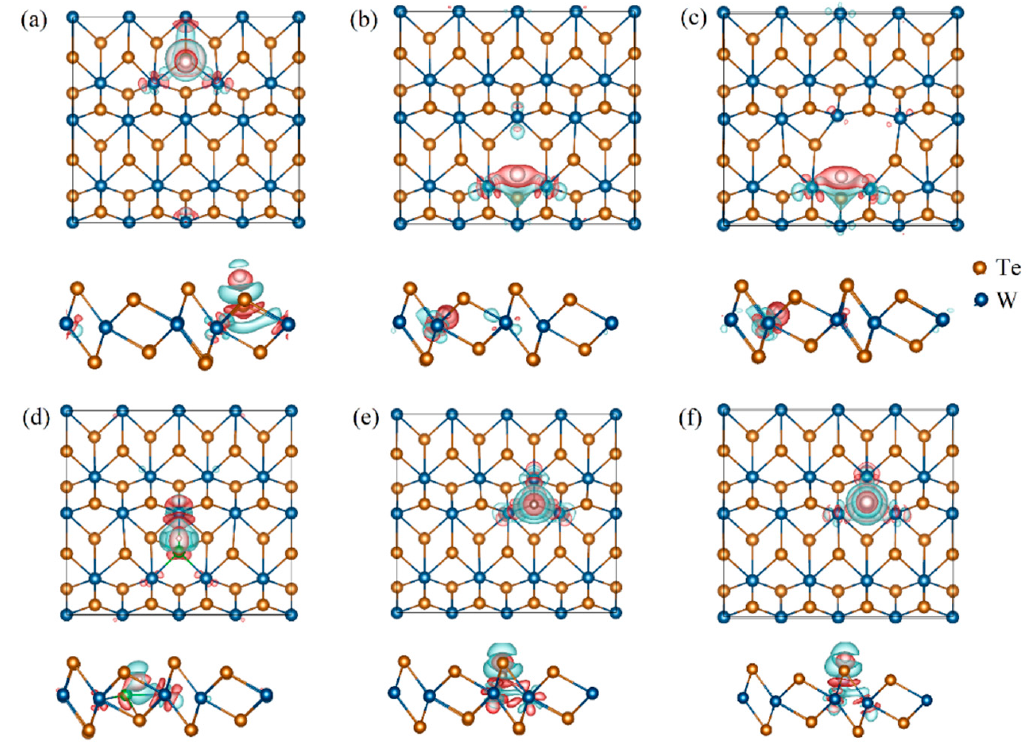
Figure 5. Difference in the charge densities of WTe 2 with an H adsorption system for ( a ) a pristine, ( b ) the single-vacancy, ( c ) the double-vacancy, and the ( d ) B-, ( e ) C-, and ( f ) P-doping from the top and side view, respectively. The red color indicates charge accumulation and green denotes charge depletion.